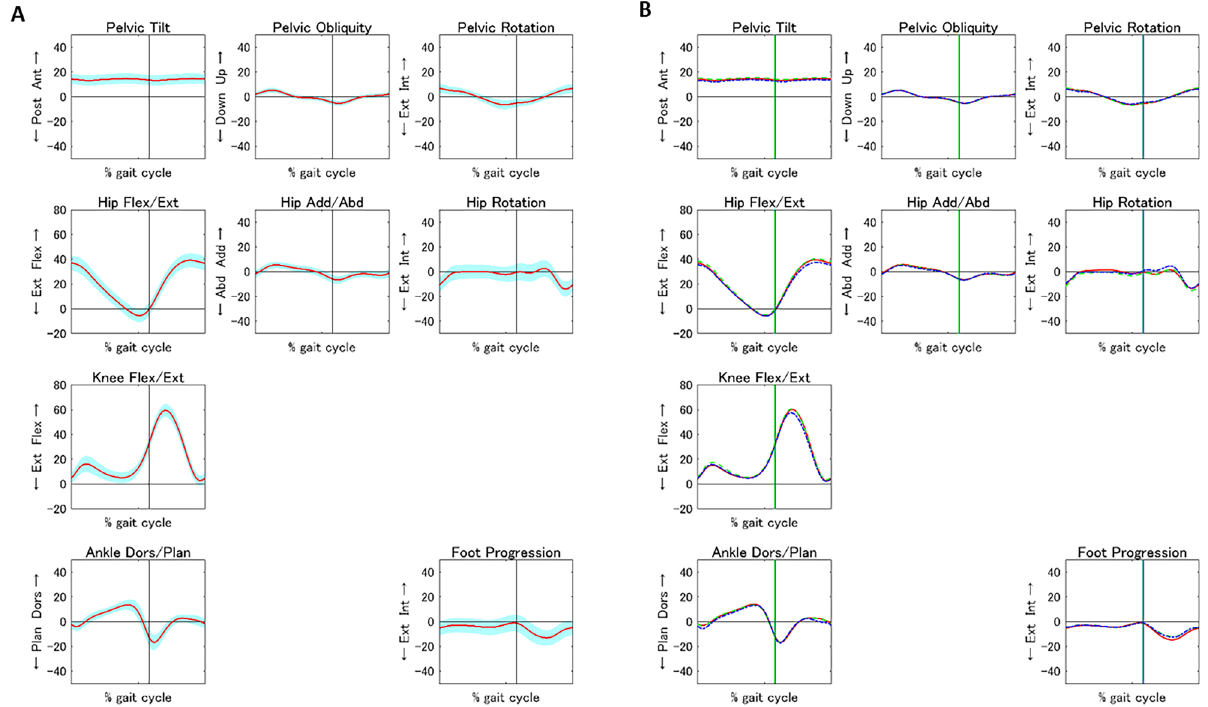
Figure 1. Mean kinematic curve generated using the values of the following gait standards in the total population and three subgroups: pelvis tilt, pelvis obliquity, pelvis rotation, hip flexion/extension, hip abduction/adduction, hip rotation, knee flexion/extension, ankle dorsiflexion/plantarflexion, foot progression . ( a ) Mean kinematic curve (red line) with the standard deviation (blue area) in the whole population. ( b ) Mean kinematic curves in the three age groups, including Groups A (6–8 years, red line), B (9–10 years, green dotted line), and C (11–12 years, blue dotted line). Abd, abduction; Add, adduction; Ant, anterior; Dors, dorsiflexion; Ext, extension or external; Flex, flexion; Int, internal; Plan, plantarflexion; Post,